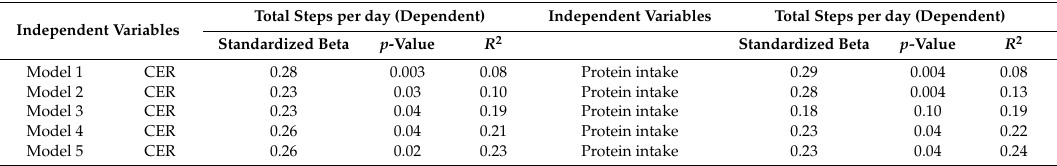
Table 2. Multivariate linear regression analyses on the associations between CER, protein intake and total steps/day (dependent variable) Independent Variables